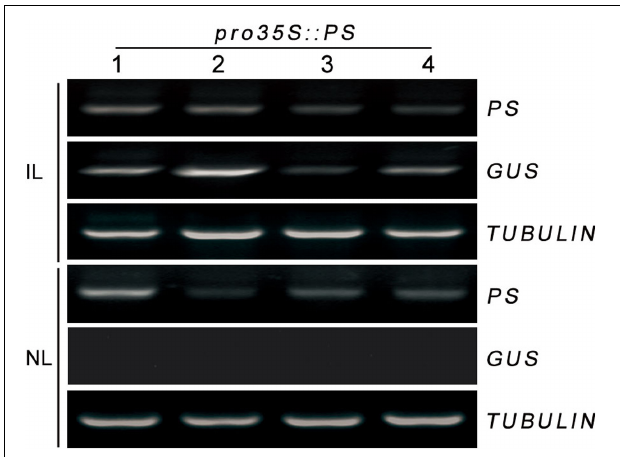
FIGURE 2 | RT-PCR analysis of mRNA levels of PS in infiltrated and non-infiltrated leaves of tomato. In a 1-month-old plant, lower leaves were infiltrated with Agrobacteria harboring pro35S::PS plasmid. The infiltrated and non-infiltrated leaves were harvested at 4 days post-infiltration and the transcript levels of PS were analyzed by RT-PCR, respectively. Expression of TUBULIN and GUS served as controls. IL, infiltrated leaves; NL, non-infiltrated leaves.